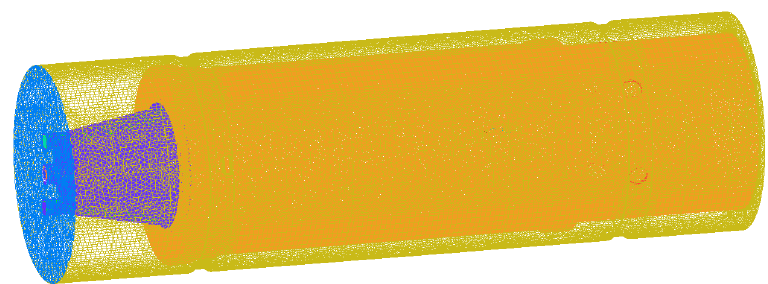
Figure 7. The computational meshes composed of the model combustor.